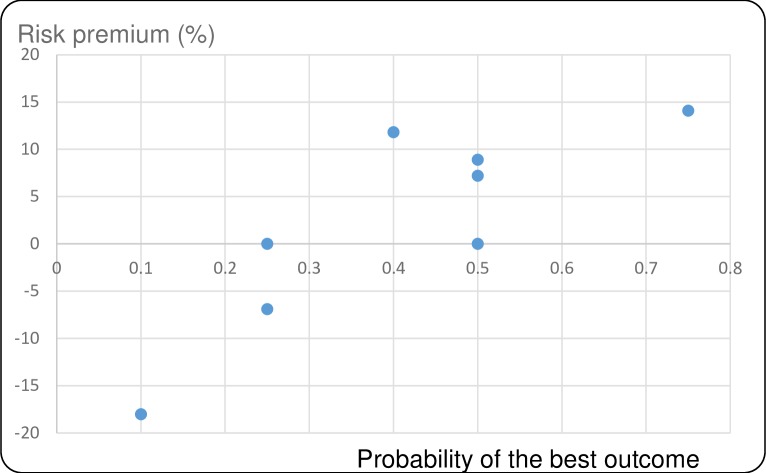
Risk premiums plotted against probability of the best outcome in the gains lottery for timeliness.